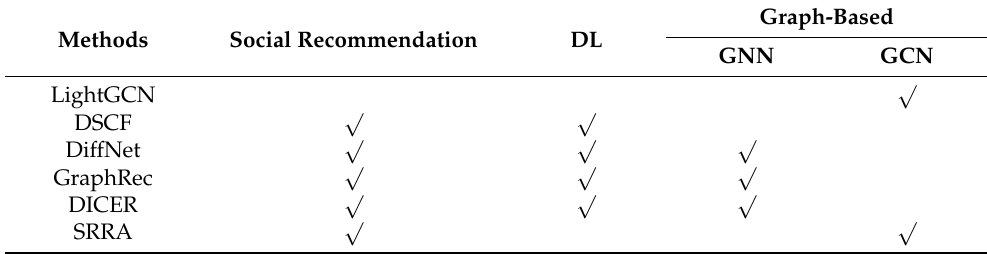
Table 2. Comparison of the model’s characteristics.